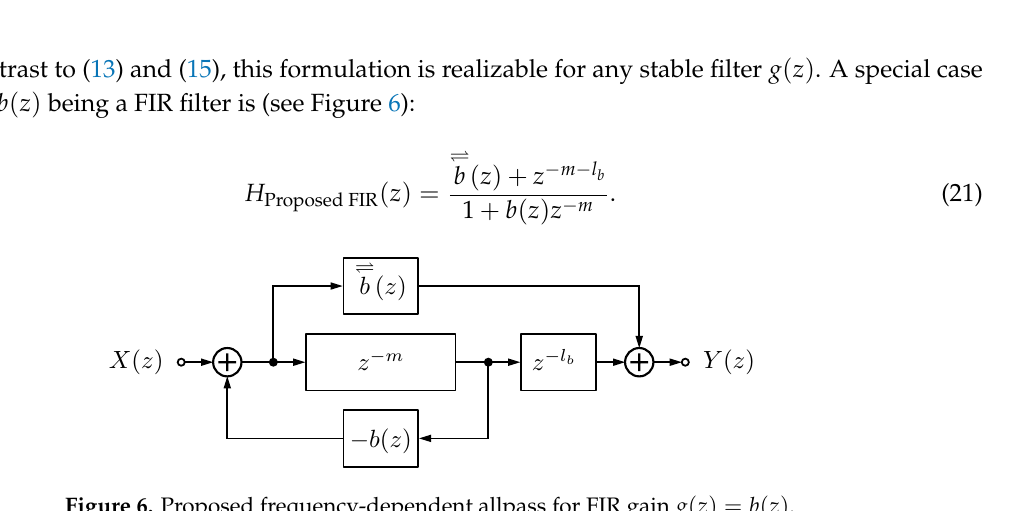
Figure 6. Proposed frequency-dependent allpass for FIR gain g ( z ) = b ( z )